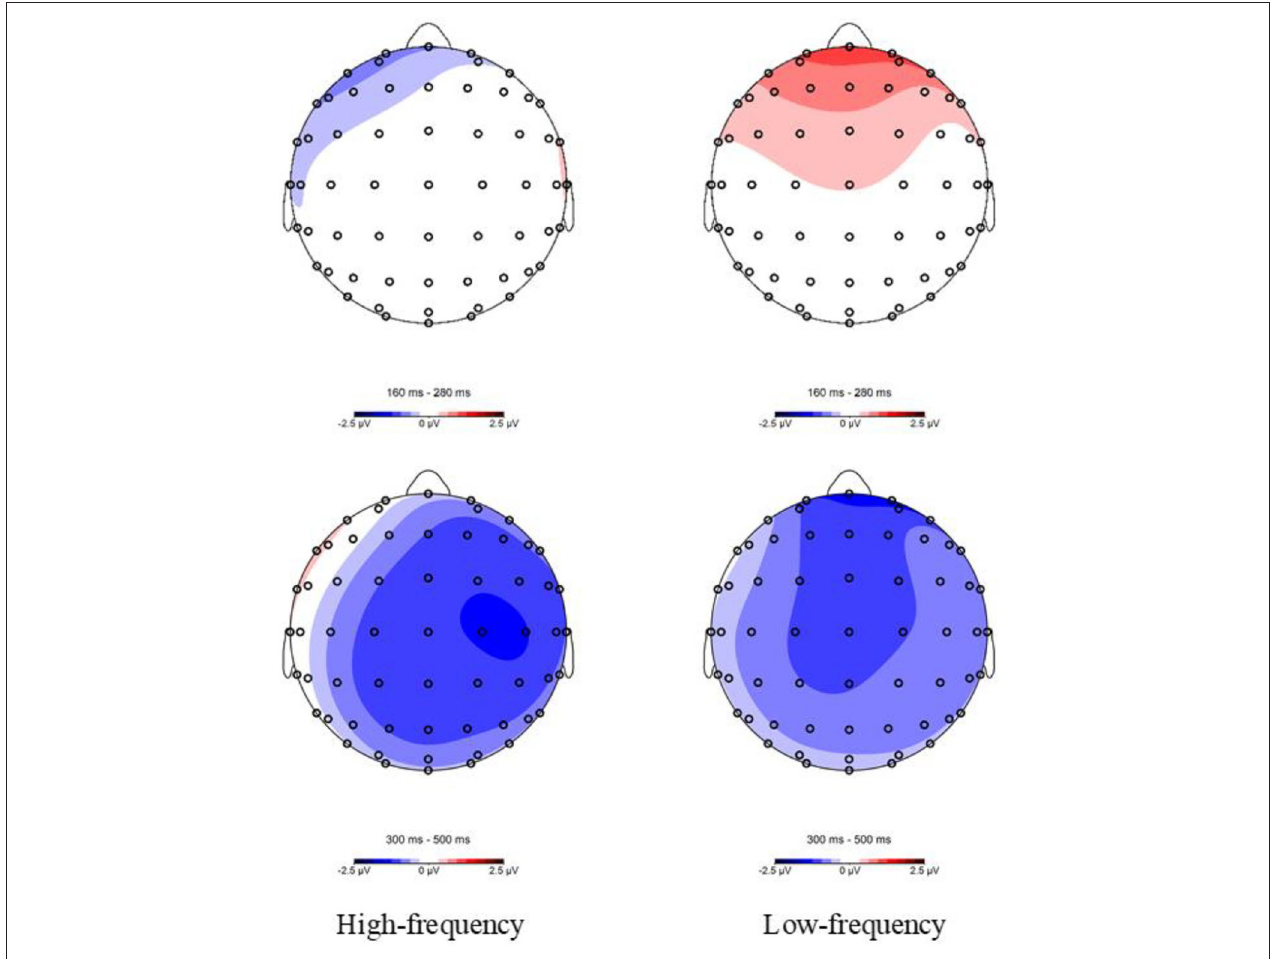
FIGURE 7 | Topographic maps of the difference waves in the homophone task for the 160–280 (semantically related minus control) and 300–500-ms (control minus semantically related) epochs following target